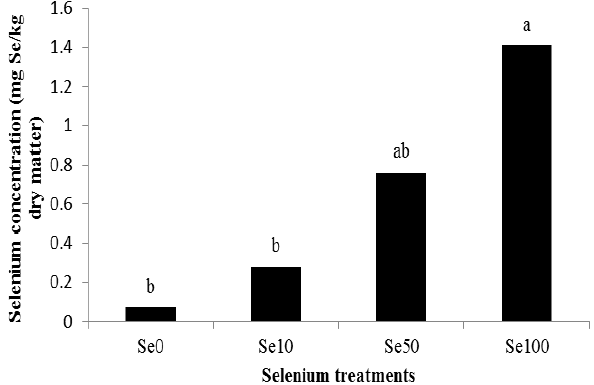
Fig. 1. Se concentration in broccoli heads as affected by different Se